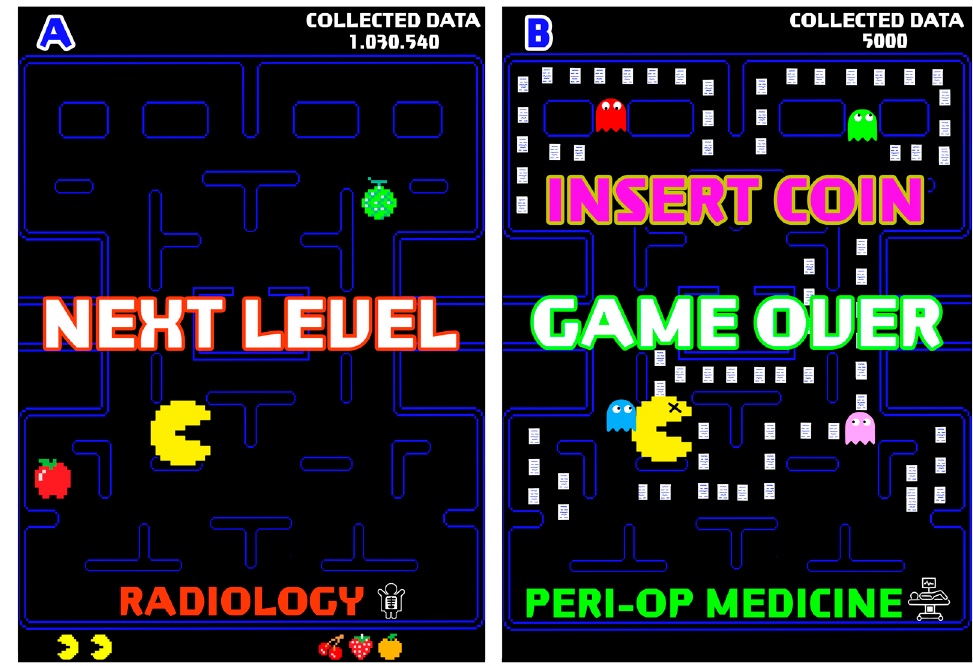
Figure 2. An example of AI in clinical practice. On the left side ( A ), the researcher manages to win the challenge about AI in radiology scenario (“NEXT LEVEL”). On the right side ( B ), the researcher fails to achieve the goal in perioperative medicine (“GAME OVER”), as many issues about AI are still to be solved in this context, represented by ghosts. “INSERT COIN” identifies the many challenges that AI faces in clinical practice before its widespread use.